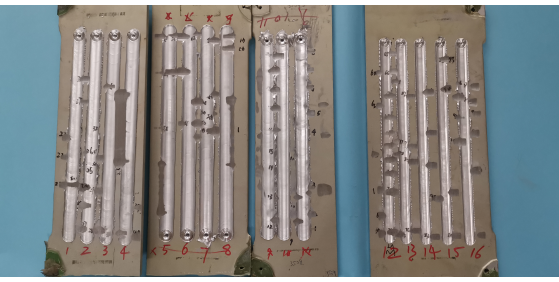
Figure 14. Weld seams after grinding.